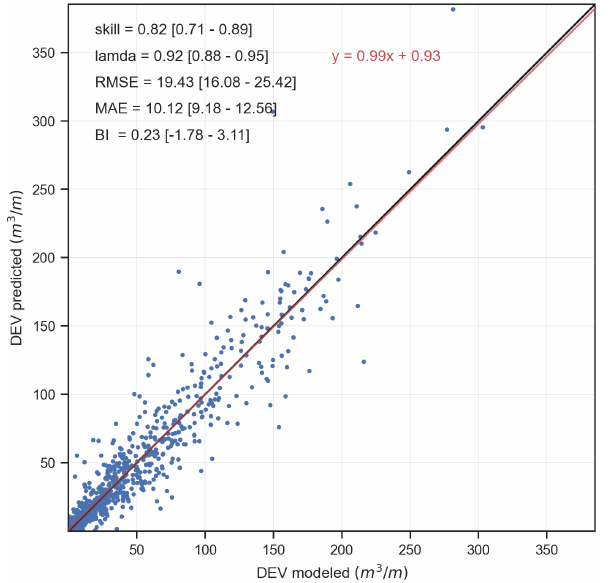
Figure 9. Scatterplot between the XBeach-simulated ( x axis) and ANN-predicted ( y axis) DEV for the validation cases with DEV > 0m 3 m − 1 using the selected regression ANN configuration (three hidden layers of 32 neurons each). The scatterplot shows the vali- dation cases for one of the randomizations, while statistics in the upper left show the mean over the 10 randomizations of the bench- mark cases, with brackets giving the min–max values. The black line indicates the 1 : 1 line, while the red line is the linear regression fit (equation given in red).